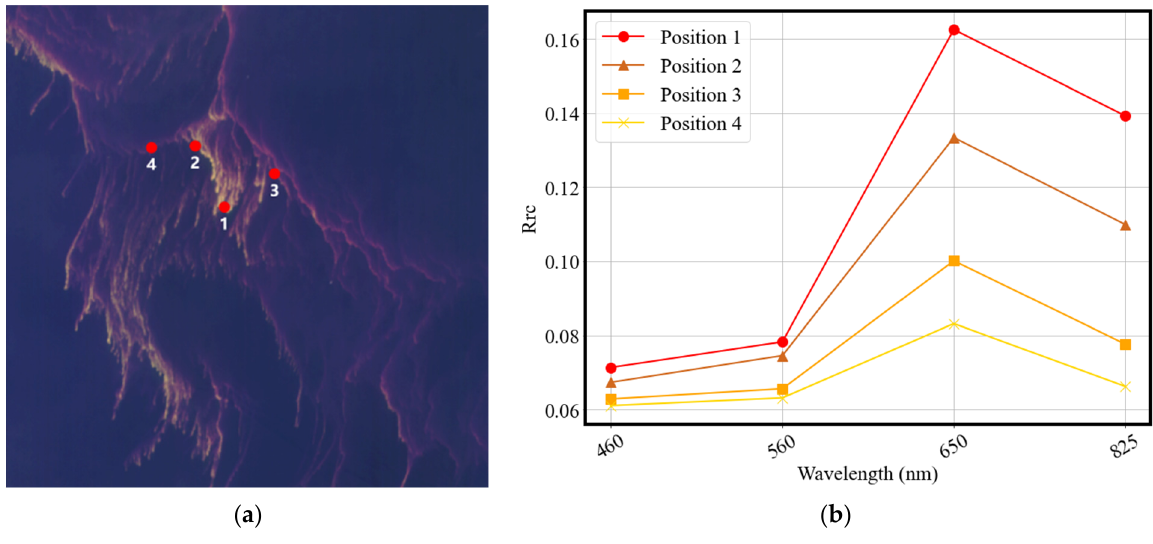
Figure 3. Spectral re fl ectance of NSB at di ff erent locations in the CZI image. ( a ) Locations of four points with di ff erent abundances; ( b ) Spectral re fl ectance of NSB at the four points.